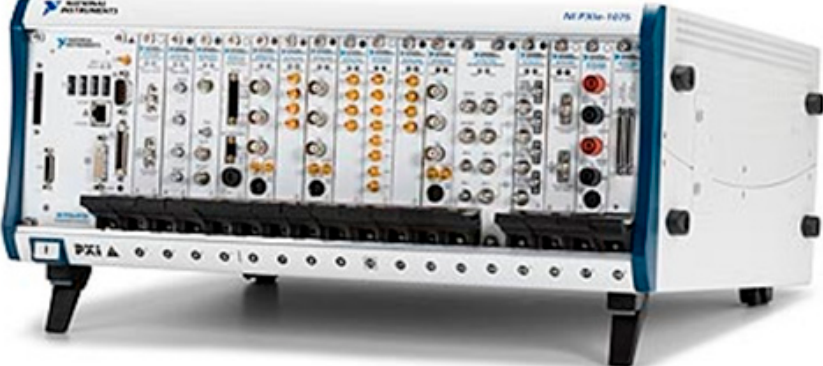
Figure 10. Collection device with RF signal acquisition function of three channels.